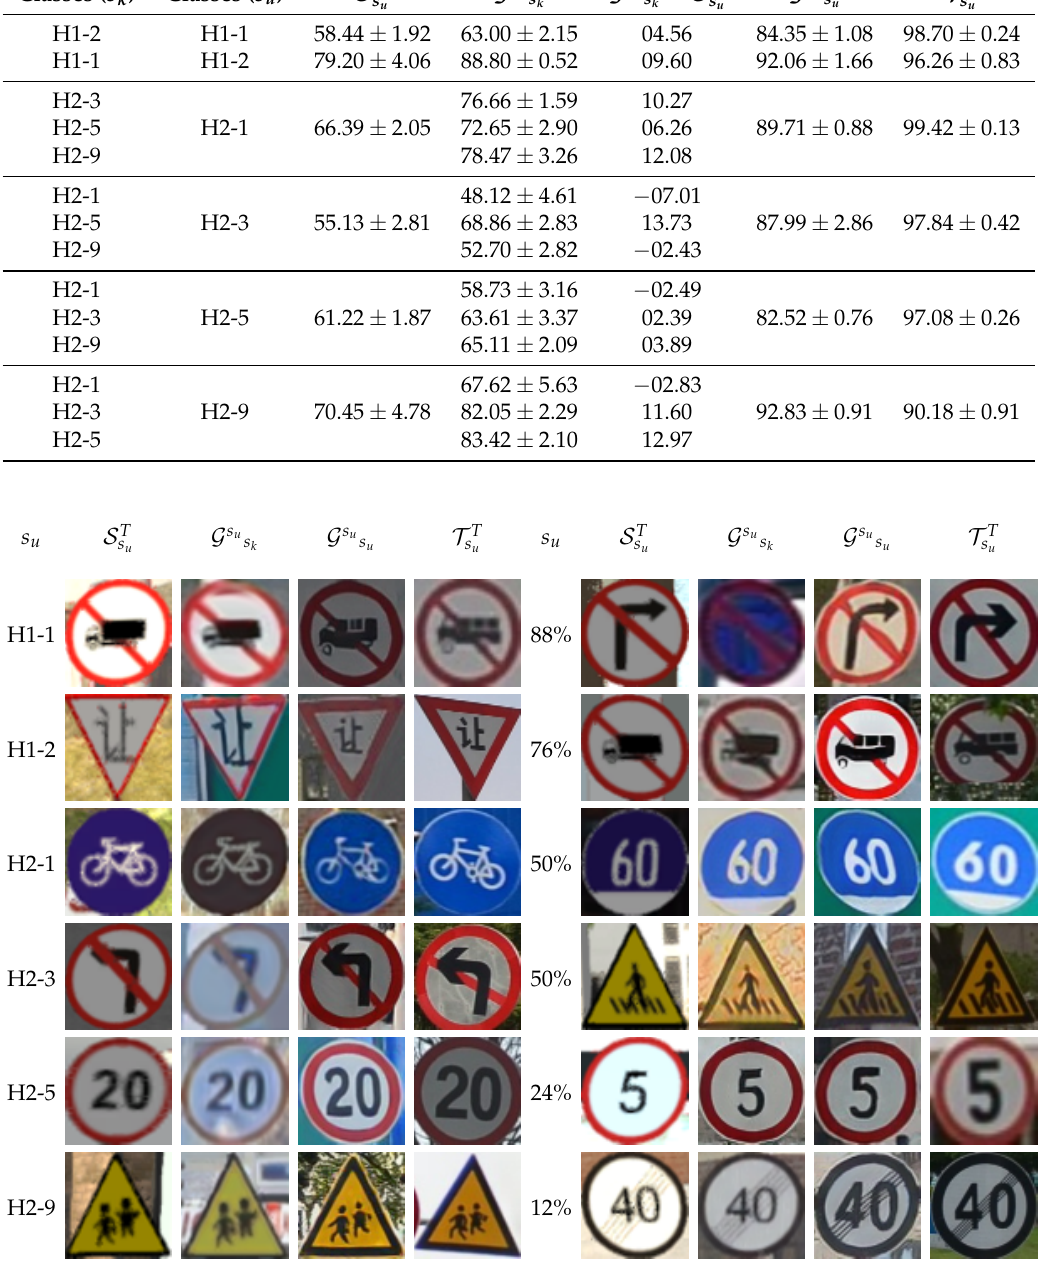
Figure 4. Sample images. The left block (4 columns) and right block (4 columns) rely on different criteria to generate their splits. Left block: Splits based on the hierarchy shown in Figure 3. Right block: Splits based on the balance between known and unknown (shown %) classes. Within each block, row-wise, we show samples from the same class of the unknown split. Within each block, from the left to the right column, we have: A SYNTHIA-TS sample from the unknown class, a SYNTHIA-TS sample from an unknown class transformed by a CycleGAN trained on SYNTHIA-TS-to-Tsinghua samples from known classes, as in the previous column but training a CycleGAN on the unknown classes, and a Tsinghua sample of an unknown